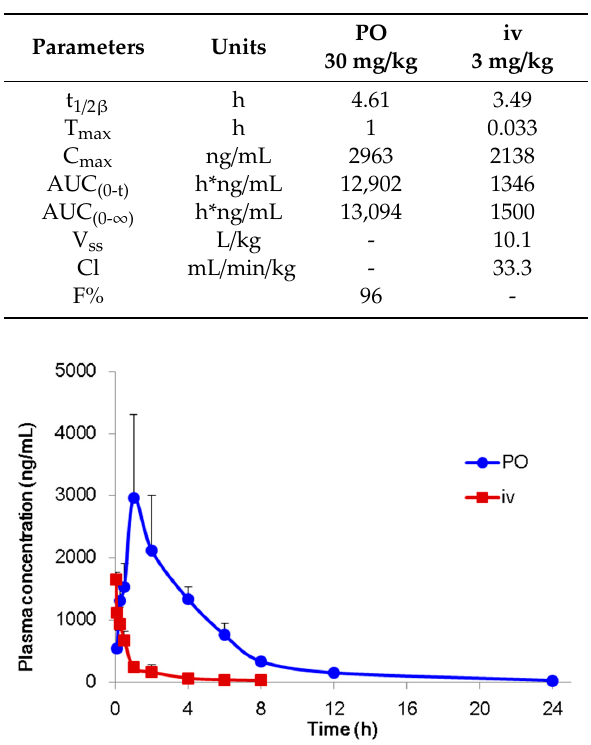
Table 5. Pharmacokinetic parameters of DX-03-12 after a single oral or intravenous dose in male ICR mice.